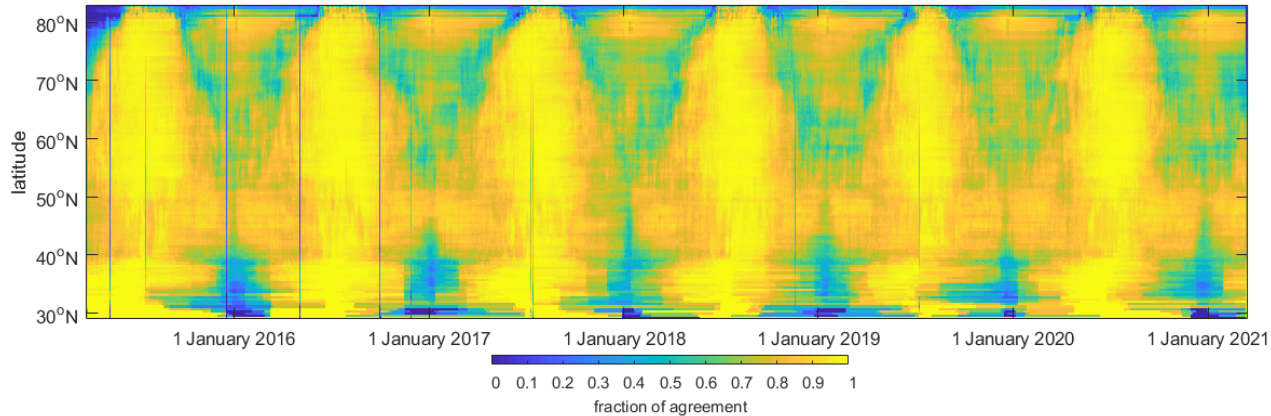
Figure 8. The fraction of agreement time series along the latitudes.